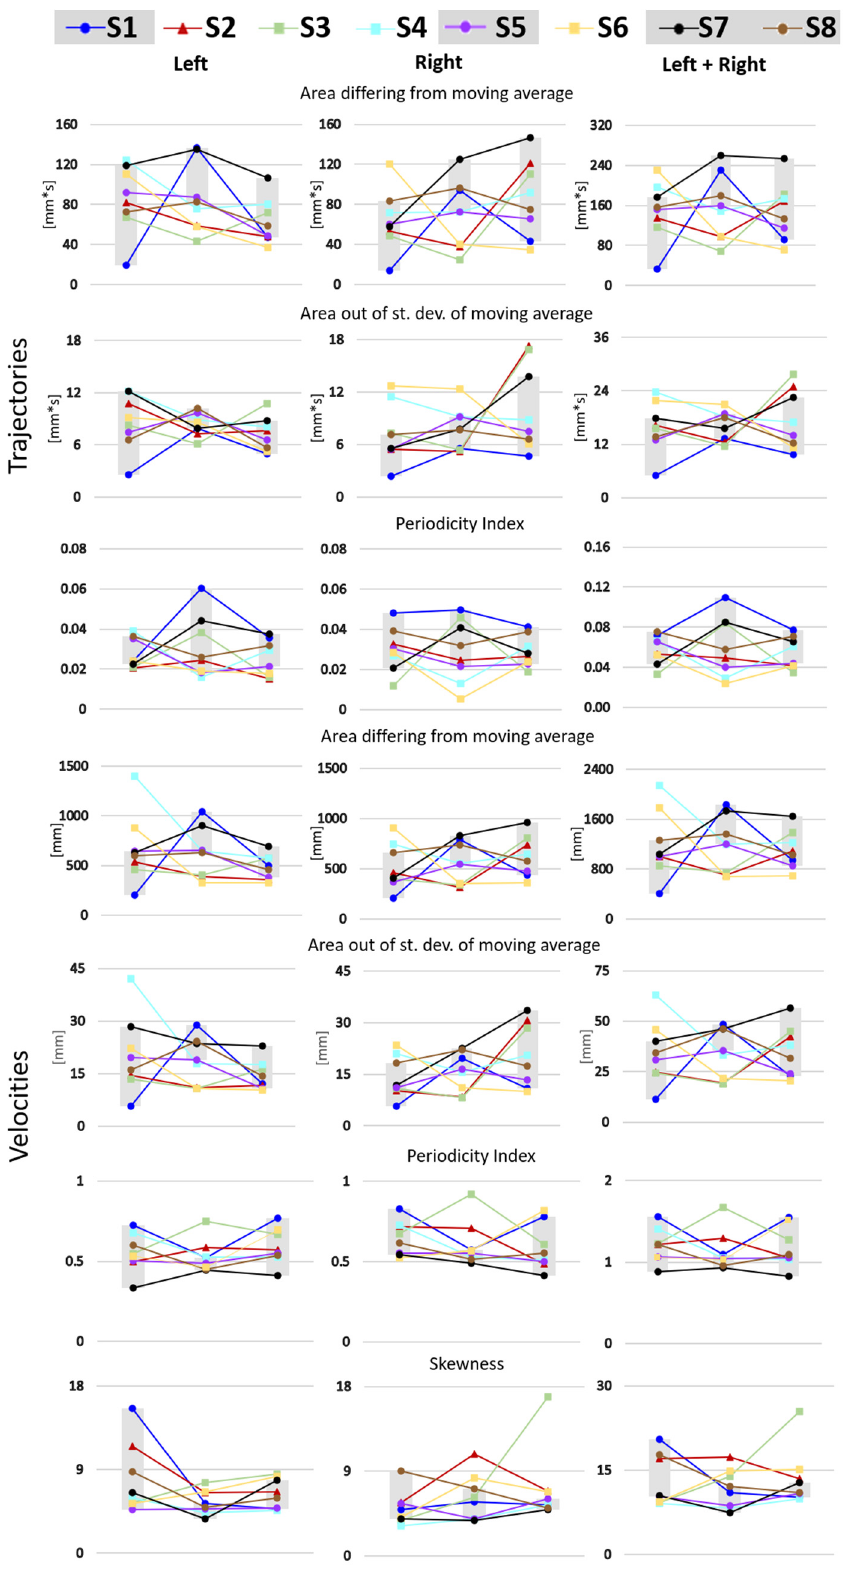
Figure 4. Metrics obtained from wrist trajectories and velocities for each infant at each timepoint (3, 4, and 5 months). Infants not suggesting atypical development to both physicians are identified with circles, infants raising the concern of both physicians are identified with triangles, and infants differently evaluated by the physicians are identified by squares. Infants not suggesting atypical development define the gray interval at each time point.